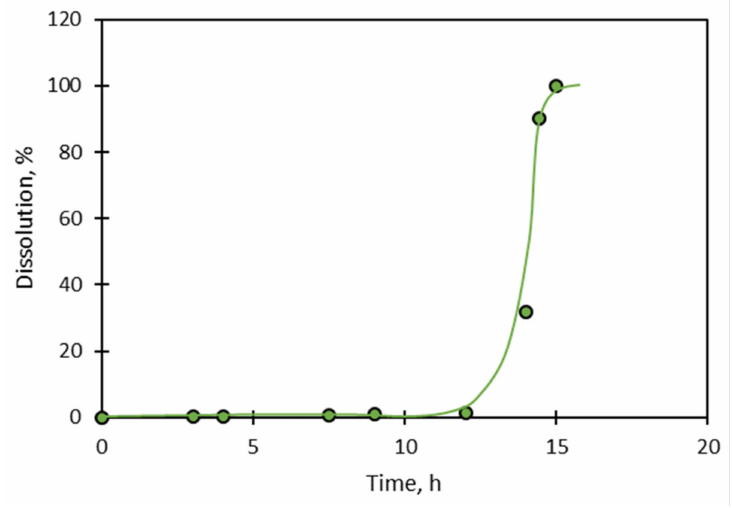
Figure 15. The acceleration of the rate of dissolution of NiO in dilute sulphuric acid at 60 ◦ C. Data from Lussiez et al.